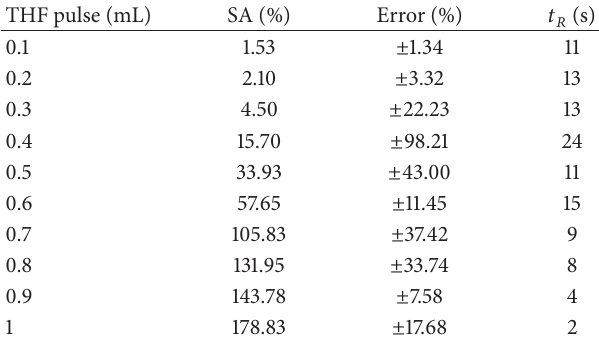
Table 2: Sensitivity average (SA), error percent, and response time for the progressive sensing